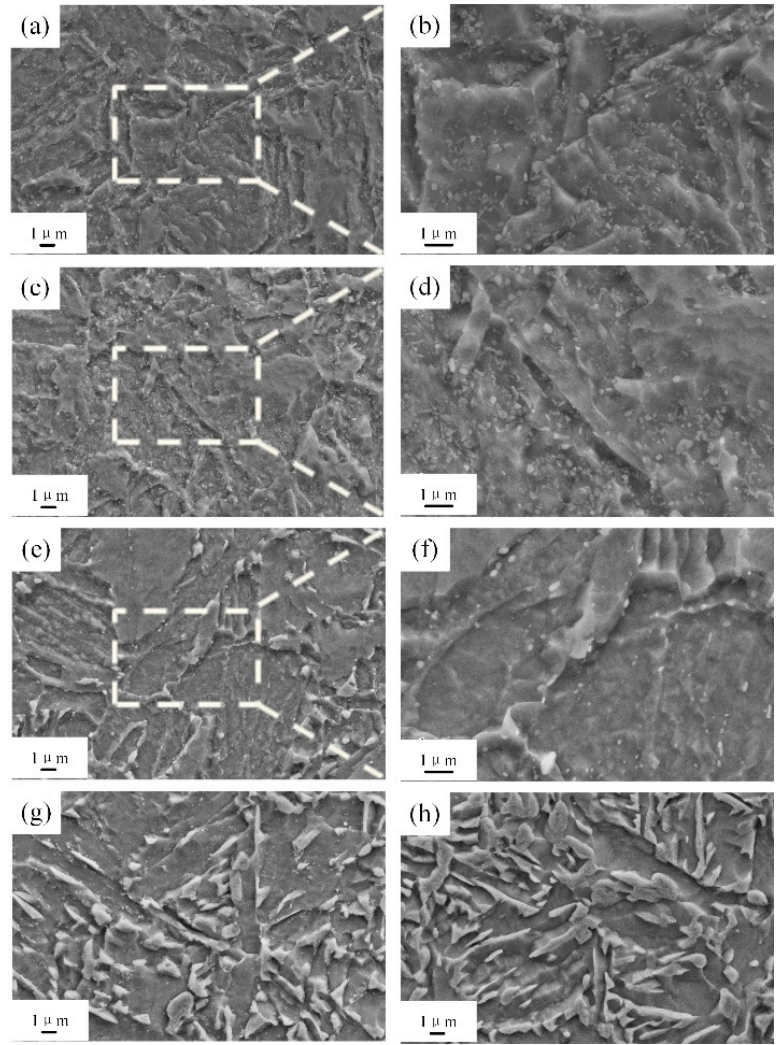
Figure 3. SEM images of SA738 Gr.B steel tempered at different temperatures: ( a , b ) 630 °C; ( c , d ) 650 °C; ( e , f ) 670 °C; ( g ) 690 °C; ( h ) 710 °C .